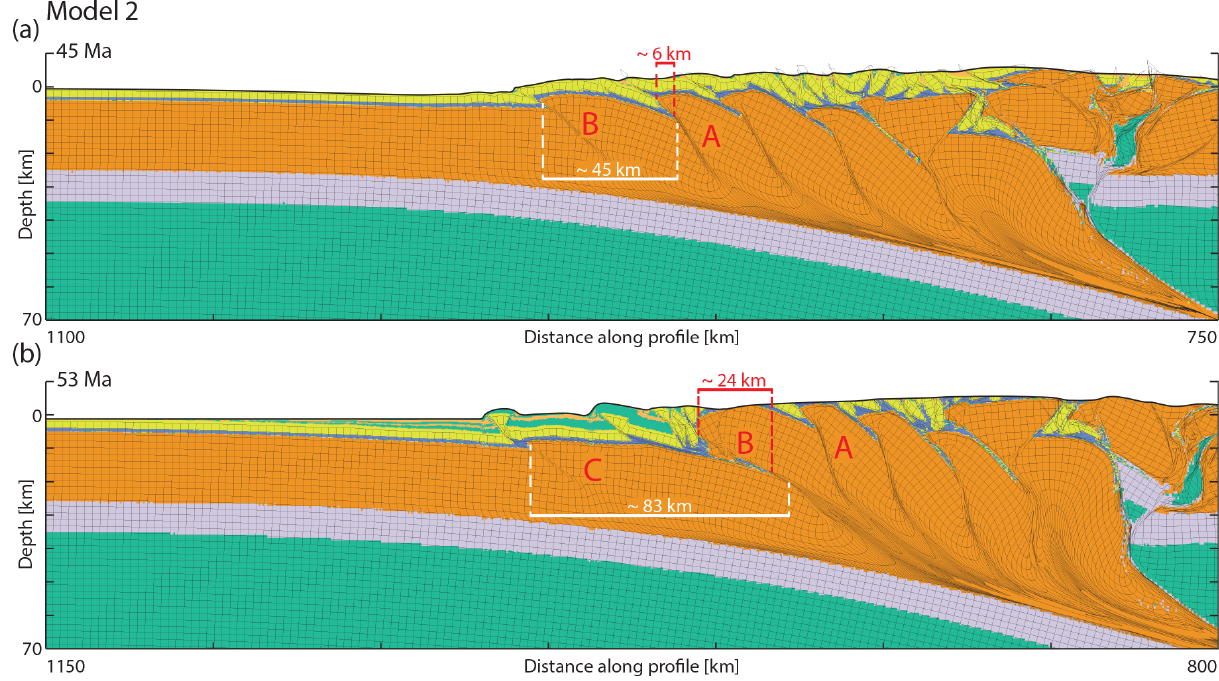
Figure 4. The evolution of Model 2 around the time of the onset of sedimentation (and erosion). The material coloring scheme is identical to that used in Fig. 2. (a) Model 2 at 45Myr ( (cid:49)x = 150km), just before the onset of sedimentation. White marks show the length of the active external basement thrust sheet (thrusting along Thrust B). The length is measured using the VISU Grid (black grid advected with the materials in the model); we counted the number of undeformed cells in the top row in the basement between the old and the new frontal thrust. Red marks show the amount of displacement along the last abandoned thrust (Thrust A). (b) Model 2 at 53Myr ( (cid:49)x = 230km) at the time of the initiation of the first basement thrust sheet after the onset of sedimentation. White marks show the length of the active external basement thrust sheet (thrusting along Thrust C). Red marks show the amount of displacement along the just-abandoned thrust (Thrust B corresponding to Thrust B in Fig. 4a). Further towards the orogenic hinterland the steepened Thrust A is shown (corresponding to Thrust A in Fig.